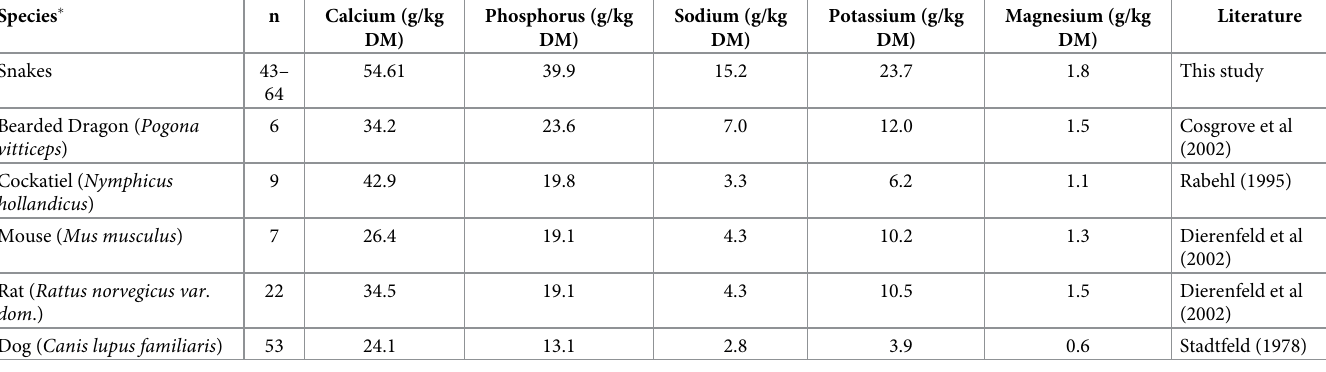
Table 9. Comparison of whole-body mineral content of different reptilian, avian and mammalian species.